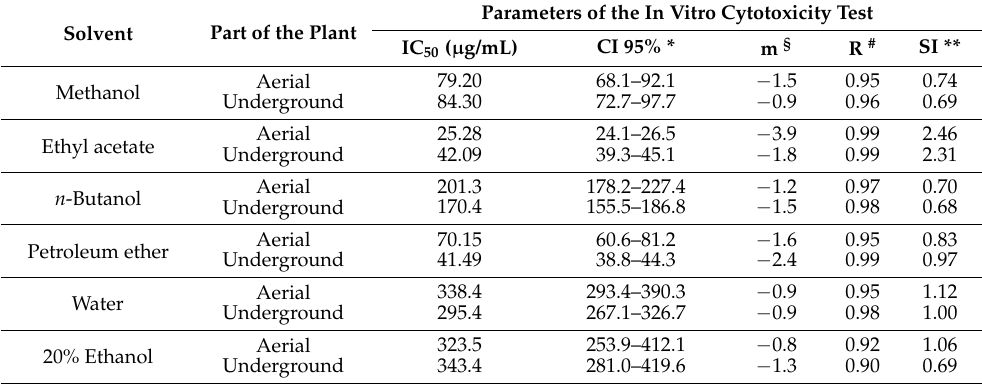
Table 2. In vitro cytotoxicity of G. urbanum extracts on the tumor cell line T-24 after 72 h of